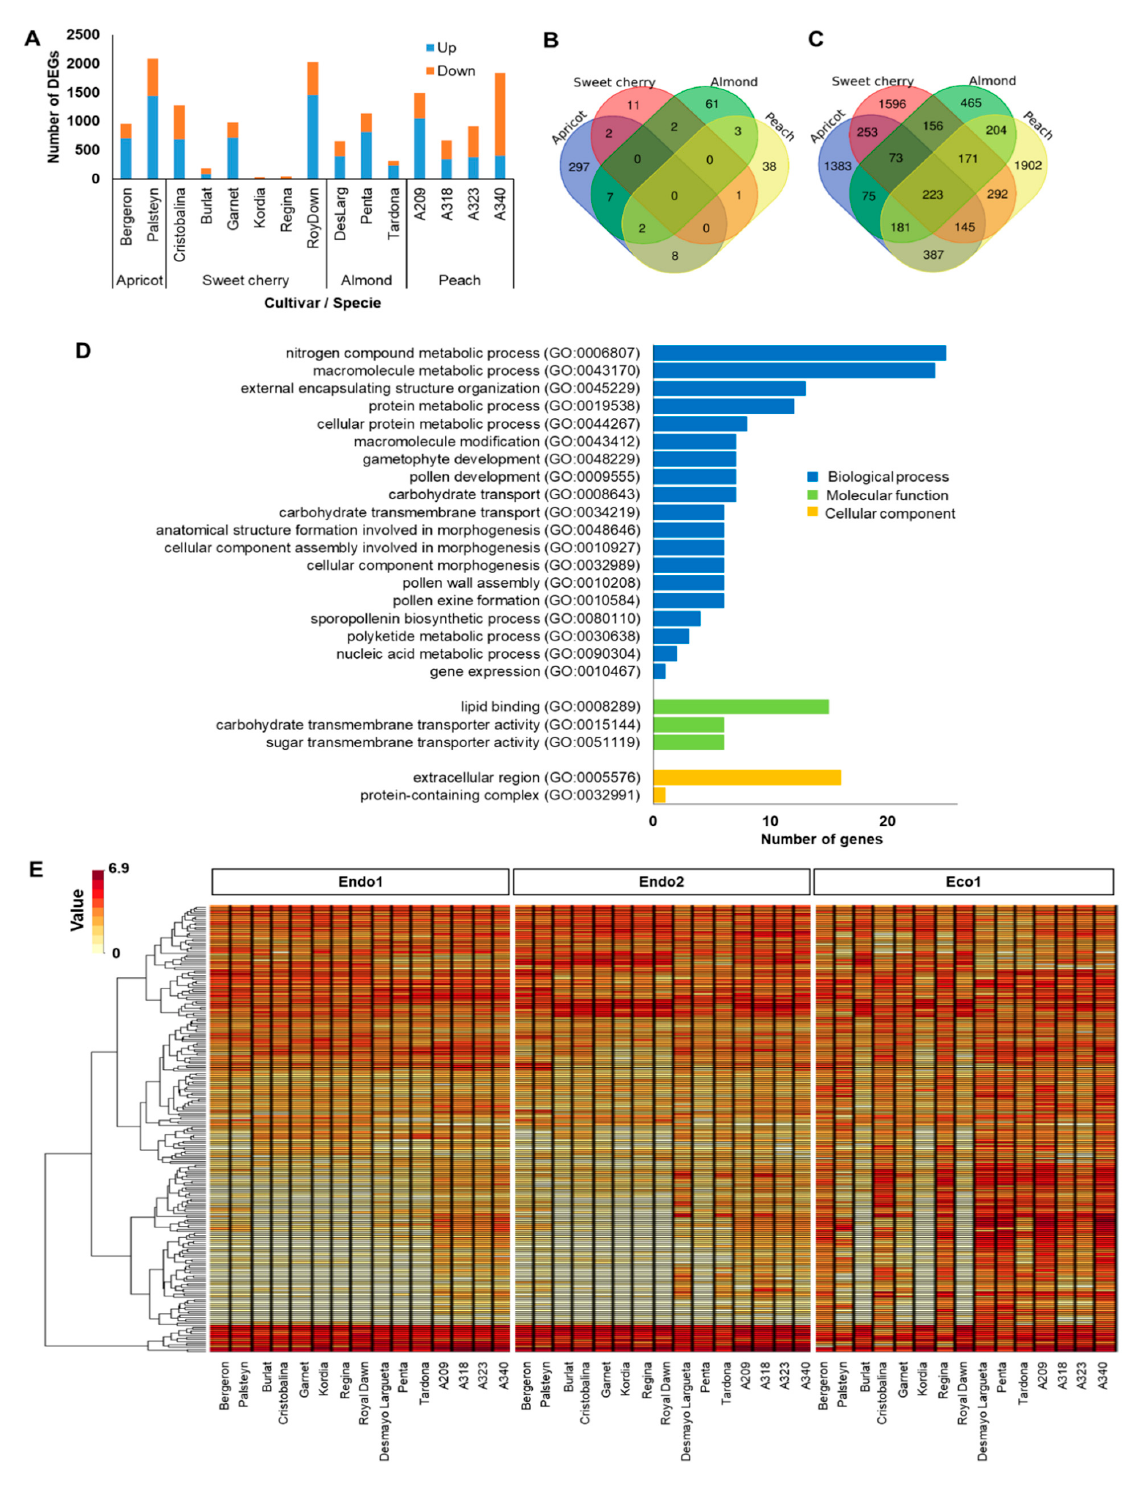
Figure 2. Summary of ecodormancy-related genes. ( A ) Number of differentially expressed genes (DEGs) in each cultivar. ( B ) Venn diagram of common DEGs in all apricot, almond, peach, and sweet cherry cultivars. ( C ) Venn diagram of common DEGs in at least one cultivar of each species. ( D ) Enrichments in gene ontology terms for biological process, molecular function, and cellular component of common DEGs in at least one cultivar of each species. ( E ) Heatmap of the 223 common DEGs in at least one cultivar of each species during dormancy.